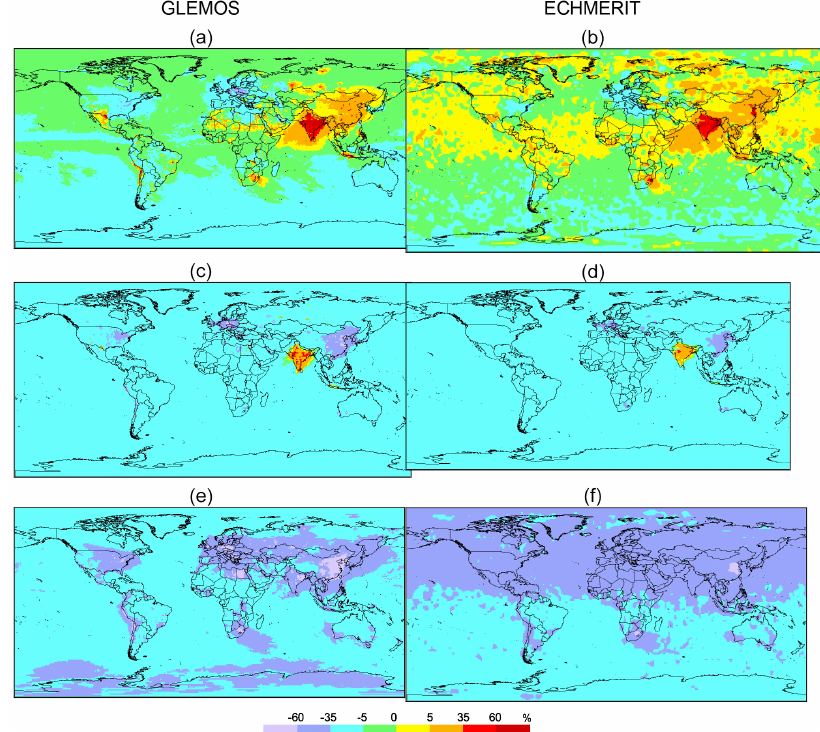
Figure 8. Global distribution of relative changes in mercury deposition flux between 2010 and 2035 with respect to three emission scenarios: (a, b) CP2035, (c, d) NP2035, and (e, f) MFR2035. Results of GLEMOS and ECHMERIT simulations are presented in the left and right columns, respectively.